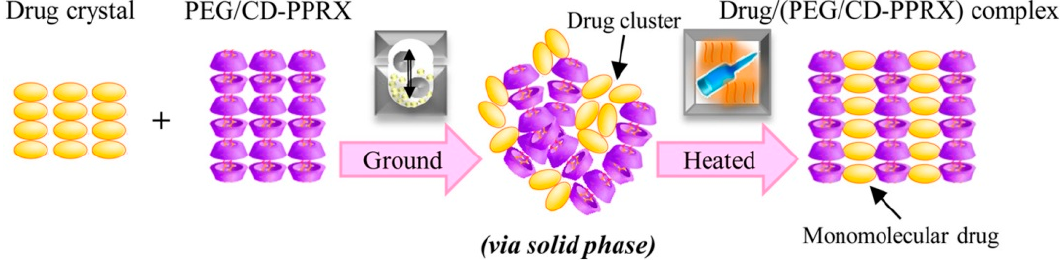
Figure 4. Illustration presenting the formation and structure of a salicylic acid/(PEG/ α -CD-polypseudorotaxane) complex. Reprinted with permission from Cryst. Growth Des. 2017 , 17 , 1055 − 1068 [103]. Copyright (2017) American Chemical Society.